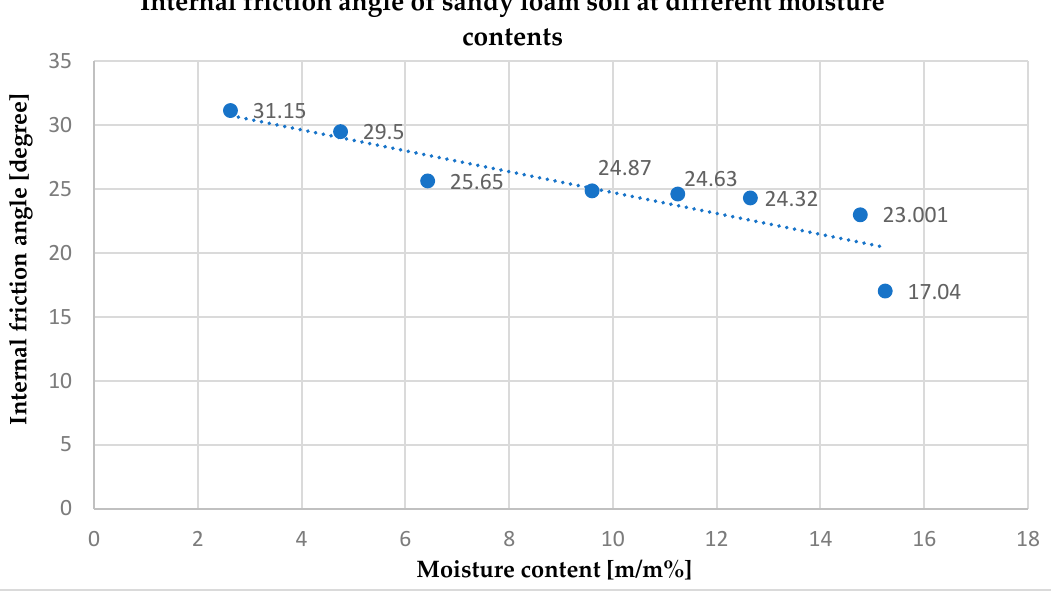
Figure 6. Sandy loam soil internal friction angle at different moisture contents.